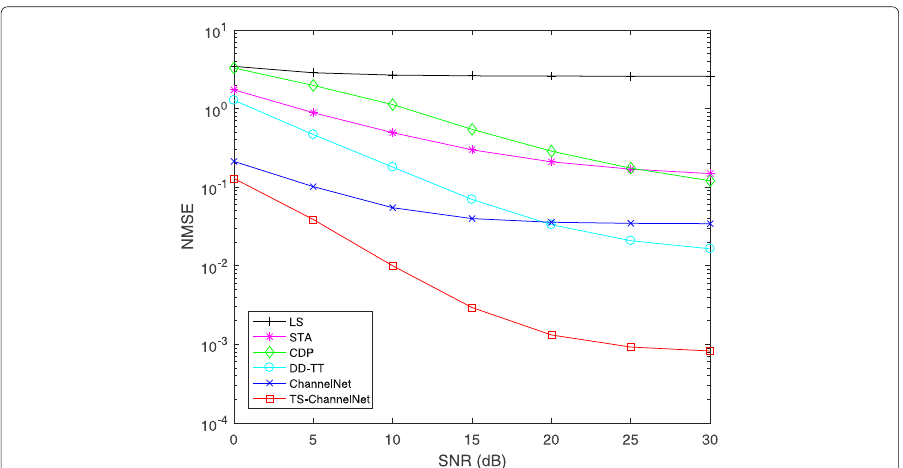
Fig. 4 NMSE with 4QAM modulation, maximum Doppler = 500 Hz, and 60 OFDM symbols (VTV Urban